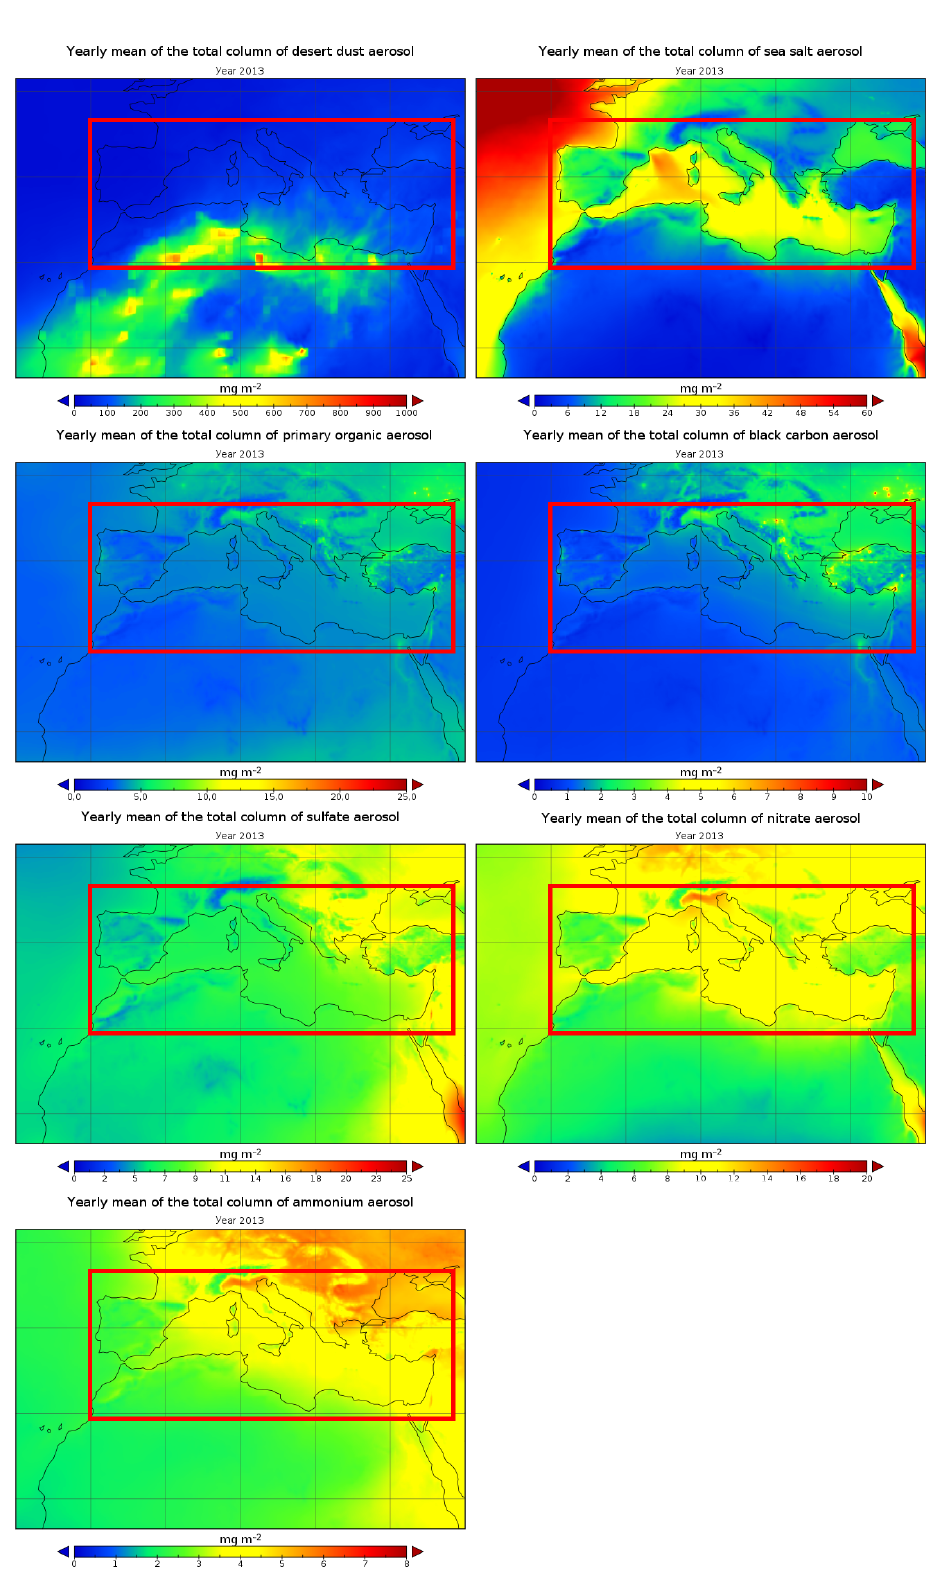
Figure 5. Yearly mean of the total column of aerosols for the year 2013. The red square on the figures represents the budget